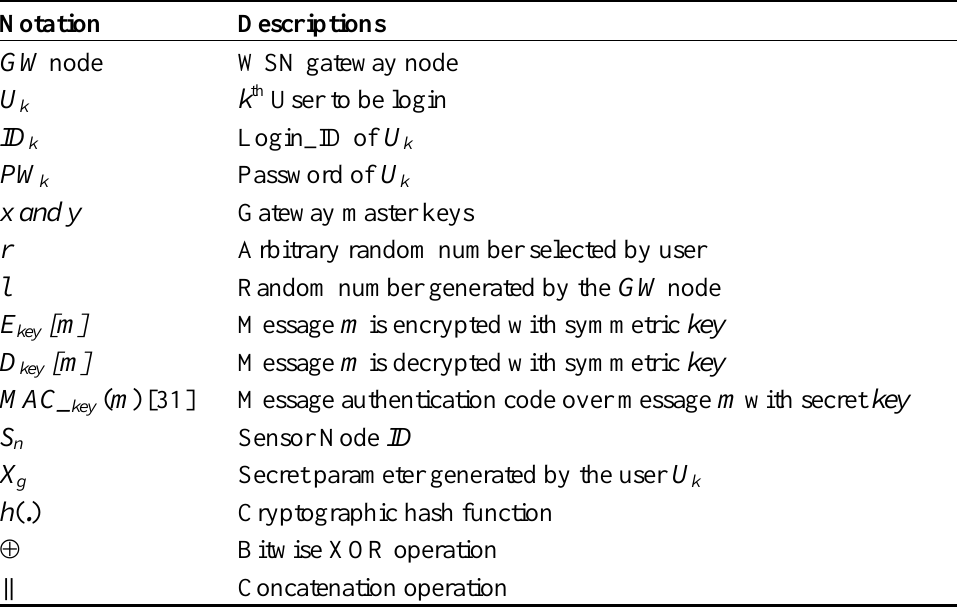
Table 1. Notation and symbols used in the